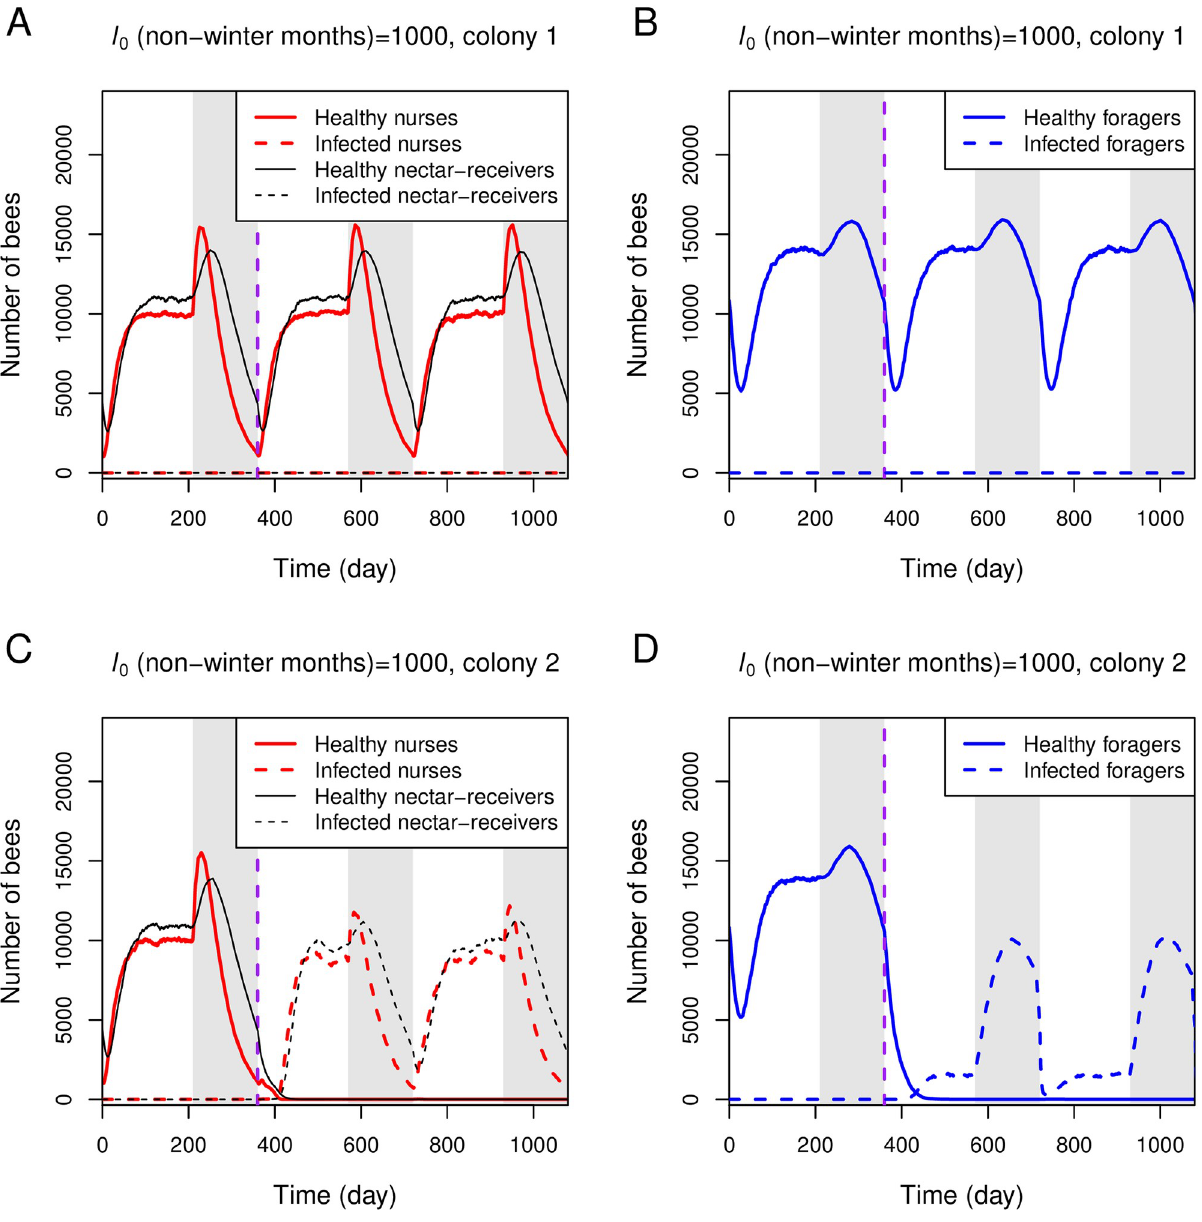
Fig 7. Stochastic simulations of the full model under seasonal effects. Stochastic simulations of two independent colonies under an identical condition are shown in upper and lower panels, respectively. Seasonal effects are implemented, as described in Fig 6 and the main text. Both colonies are simulated with the same parameter set ( l 0 during non-winter months = 1000 and other parameters from Table 1). One infected forager returning from nectar-collecting (iF 1 ) is introduced at day 360 (vertical purple